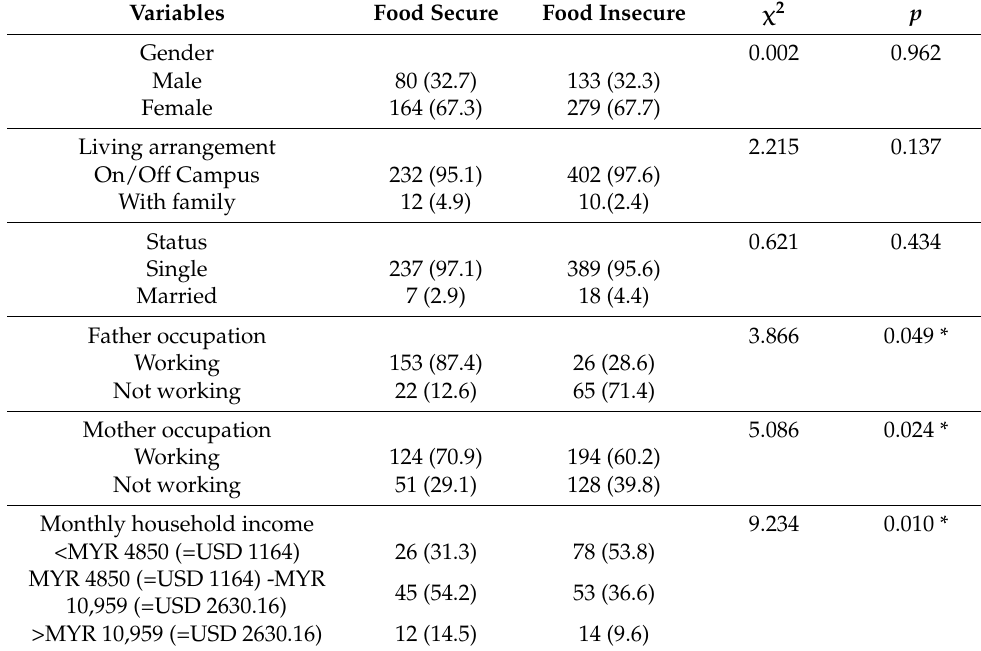
Table 2. Associations between demographic and socioeconomic, psychosocial factors and academic performance, and food security